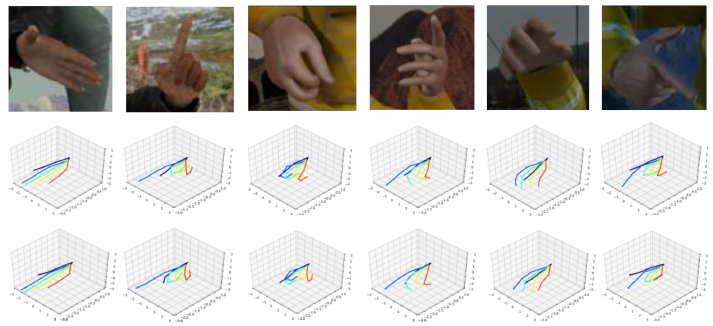
Figure 11. Qualitative results for RHD dataset